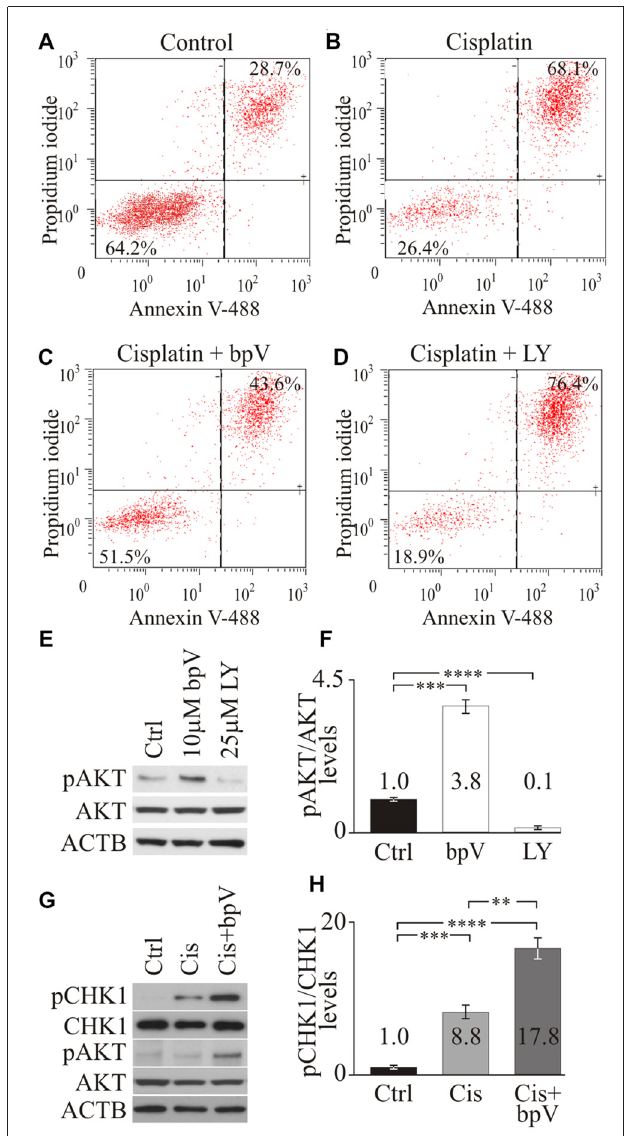
FIGURE 2 | Checkpoint Kinase 1 (CHK1) phosphorylation after activating phosphoinositide 3-kinase (PI3K) signaling. Propidium iodide (PI) and annexin V FACS analysis of (A) control dimethyl sulfoxide (DMSO), (B) cisplatin (C) cisplatin and bpV(HOpic) and (D) cisplatin and LY treated cells from representative plots. Average percentage of cells from viable (PI- annexin V-) and apoptotic (PI+ annexin V+) quandrants were displayed ( n = 4). (E) Western blot of phospho-AKT (pAKT), total AKT and ACTB in control DMSO, 10 µ M bpV(HOpic) or 25 µ M LY294002 treated cells ( n = 4). (F) Quantification of pAKT/AKT ratio from Western blots ( n = 4). (G) Western blot of pCHK1, total phospho-CHK1 (CHK1), pAKT, total AKT and ACTB